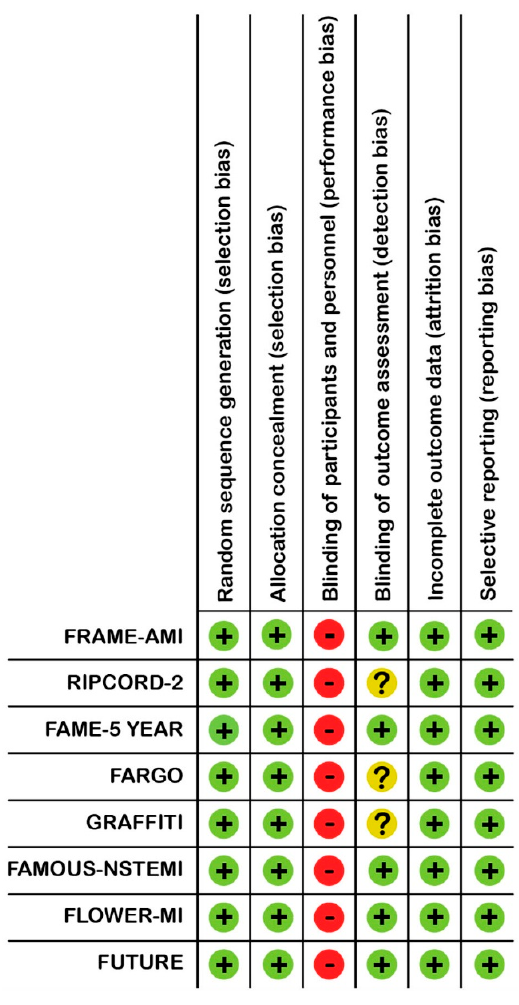
Figure 1. Risk of bias summary for the individual studies, by Cochrane risk assessment tool. + = low risk of bias, − = risk of bias, ? = unclear.